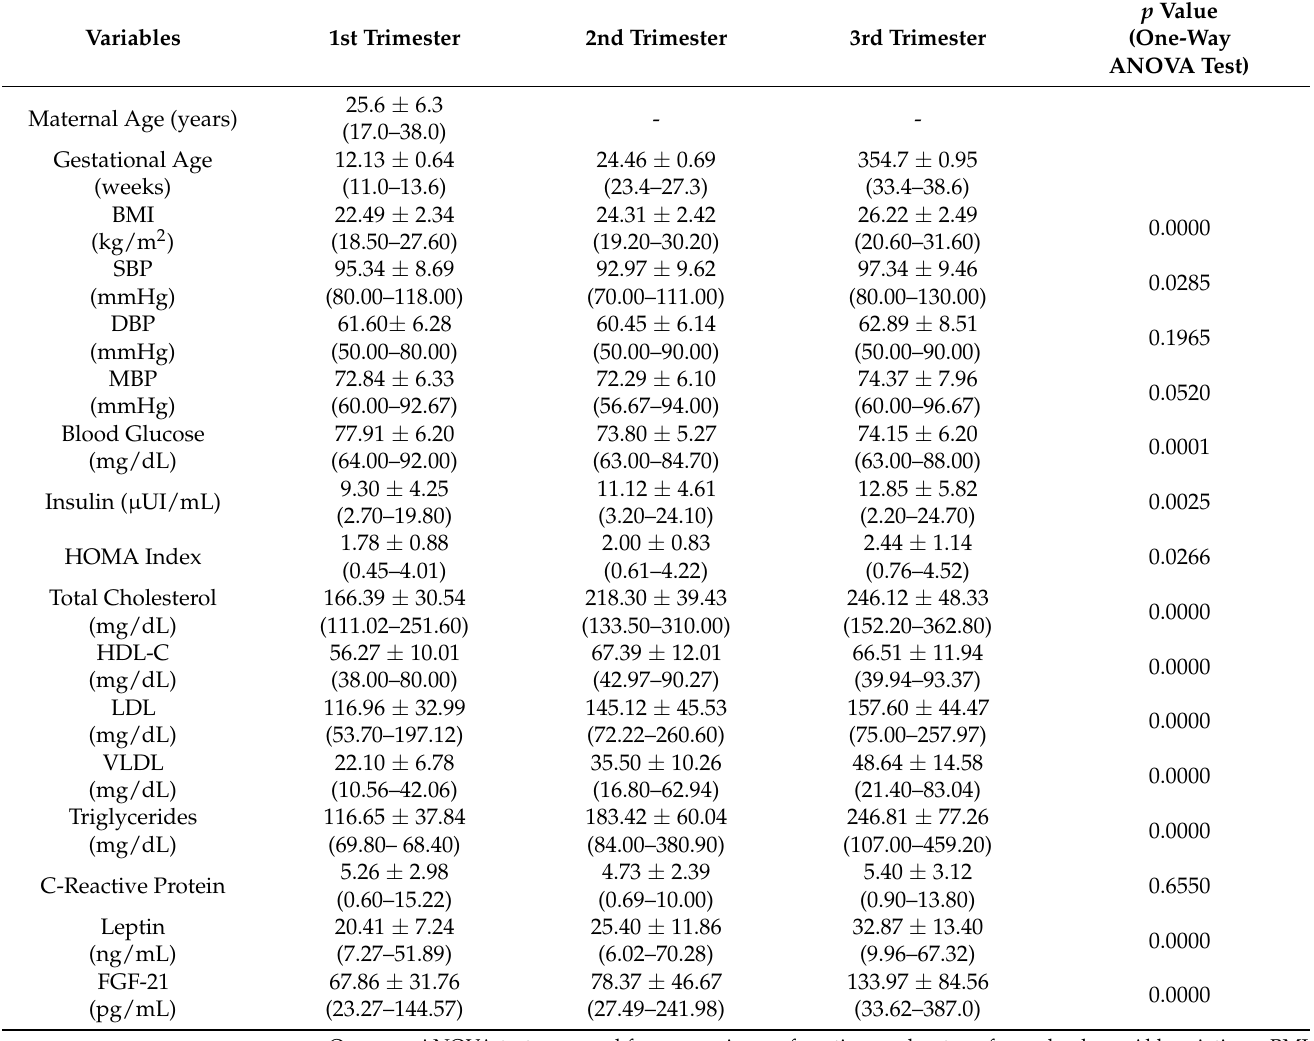
Table 1. Characteristics of healthy normotensive pregnant women during the 1st trimester, 2nd trimester and 3rd trimester of pregnancy.